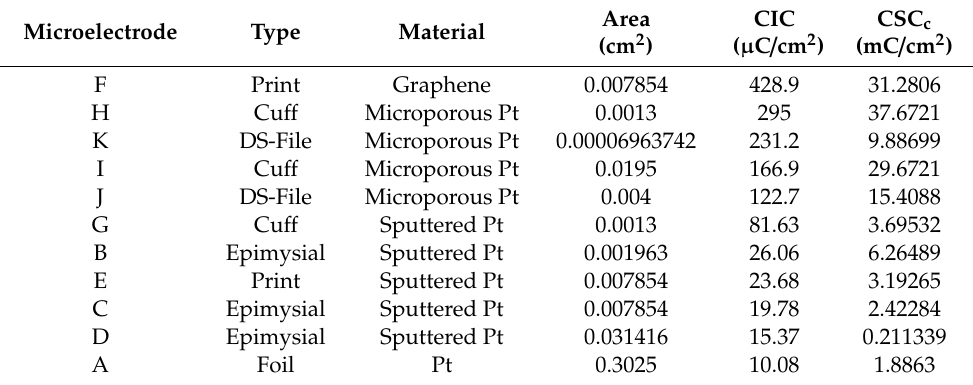
Table 8. CIC and CSC c of all electrodes of our study, sorted by decreasing